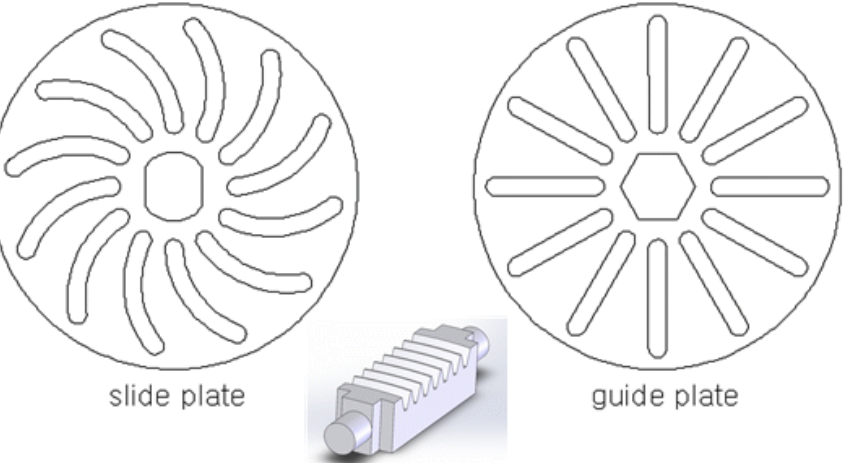
Figure 4. Slide plate designed with a normal curve and a guide plate designed with a straight line.